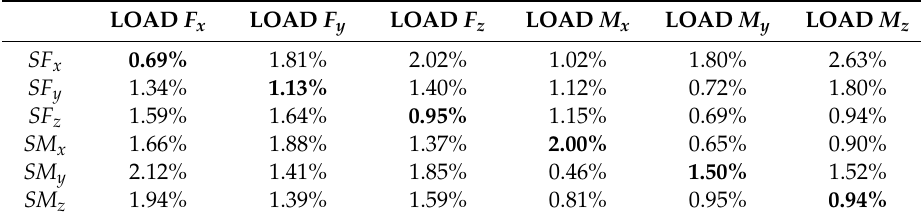
Table 8. Absolute average error